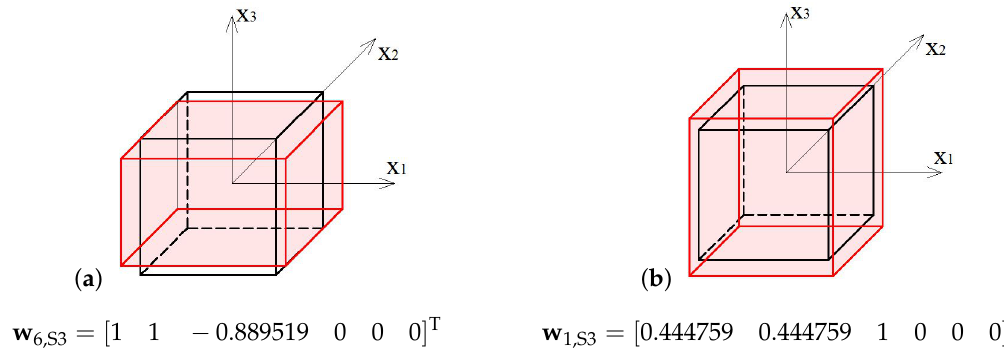
Figure 9. Deformation modes of the 3-strut simplex: ( a ) Soft mode. ( b ) Stiff mode.